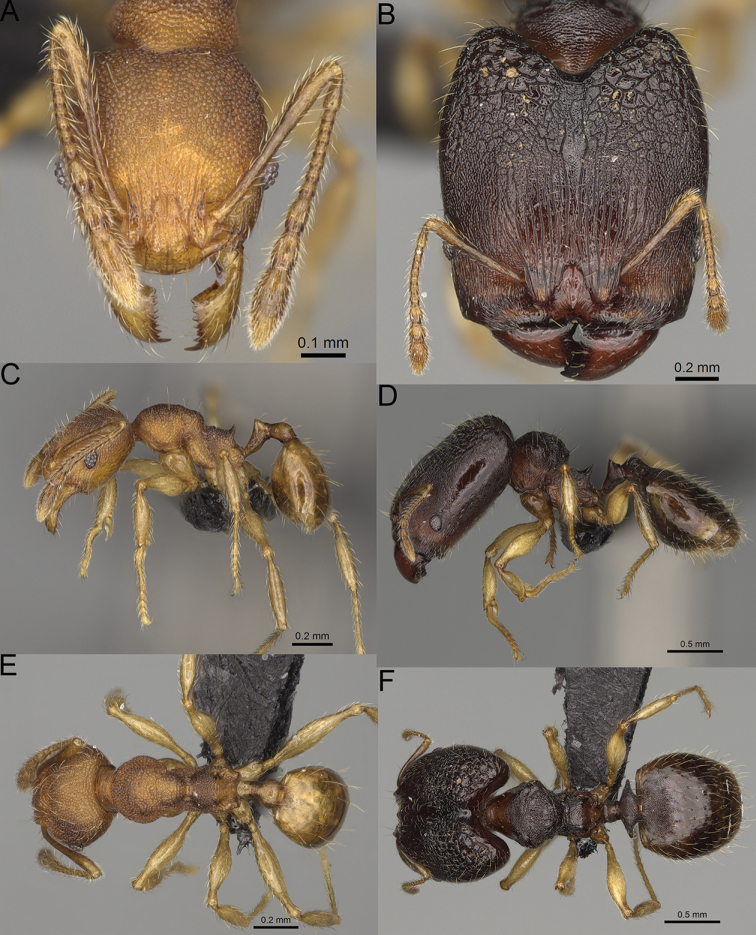
Pheidole
zavamanira sp. nov., full-face view (A), profile (C), and dorsal view (E) of paratype minor worker (CASENT0485890) and full-face view (B), profile (D), and dorsal view (F) of holotype major worker (CASENT0485886).